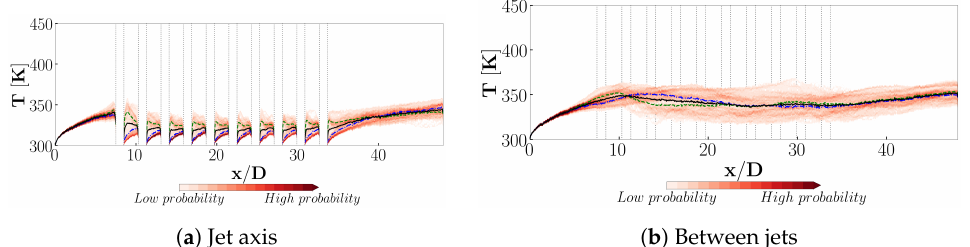
Figure 15. Probability density functions of wall temperature obtained with Φ = 1500 W.m − 2 for the turbulent inlet